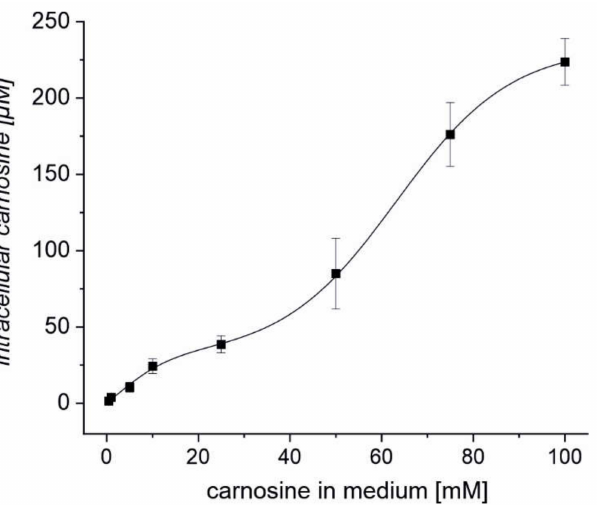
Figure 3. Intracellular concentrations of carnosine in erythrocytes exposed to different concentrations of carnosine in the medium reveal a biphasic uptake response. Erythrocytes of a healthy volunteer (male, age 29) were incubated in the presence of different concentrations of carnosine. After 4 h of incubation, the intracellular amounts of carnosine were determined using LC-MS and external standards. The concentration inside the erythrocytes was calculated assuming an average erythrocyte volume of 90 × 10 − 15 L. All measurements have been performed in triplicate. Lines represent the results of a biphasic fit with an R 2 of 0.997 and the 1st EC50 = 5.86 µ M and the 2nd EC50 = 62.65 µ